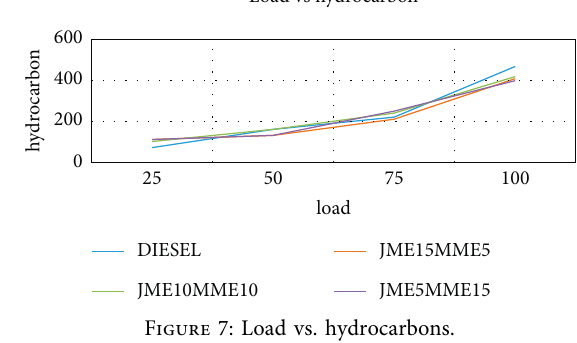
Figure 7: Load vs. hydrocarbons.